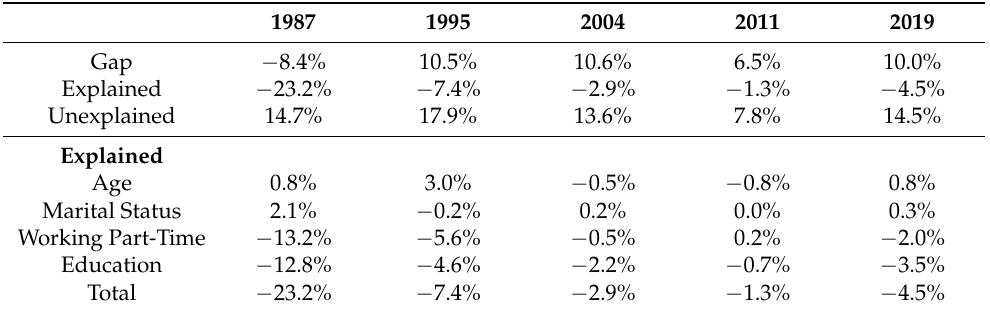
Table A5. Decomposition results from RIF regressions for selected years at the 90th